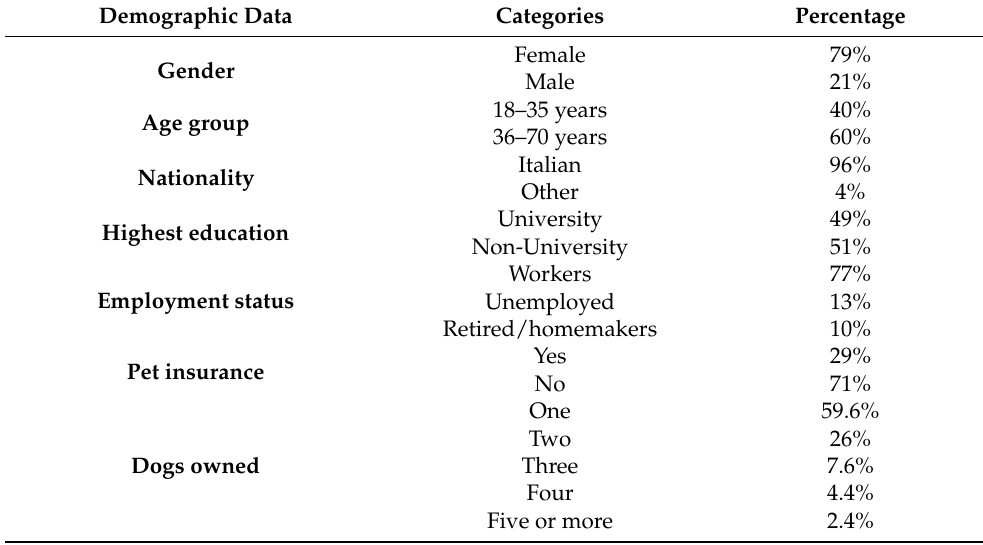
Table 1. Demographics of